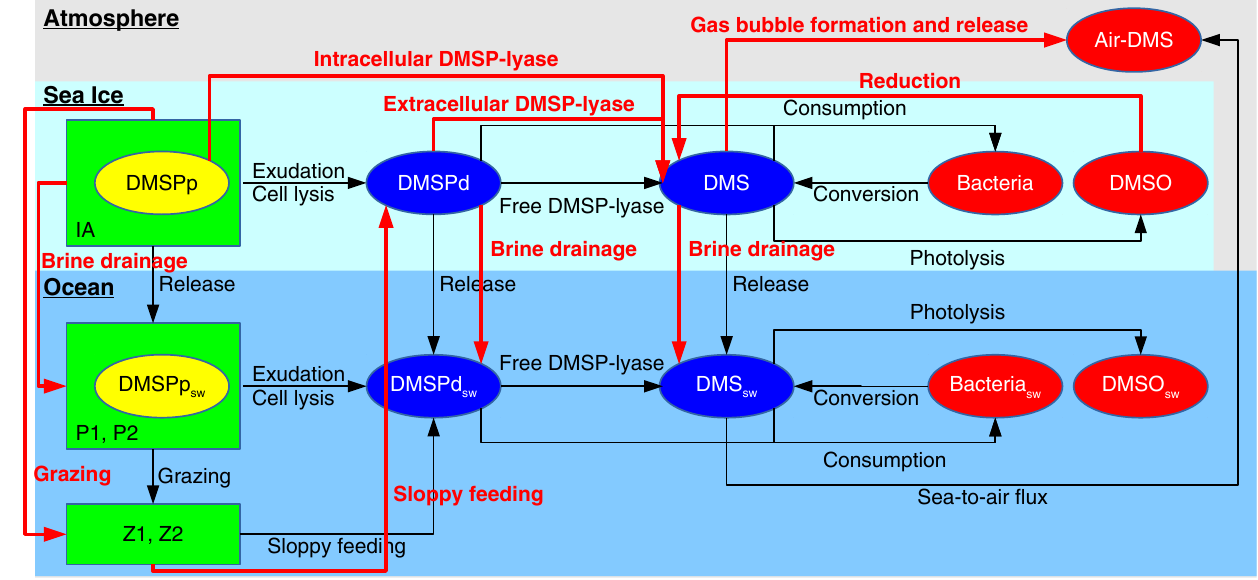
Figure 10. Same as Fig. 1, but with additional physical and biogeochemical fluxes suggested for future model development (red